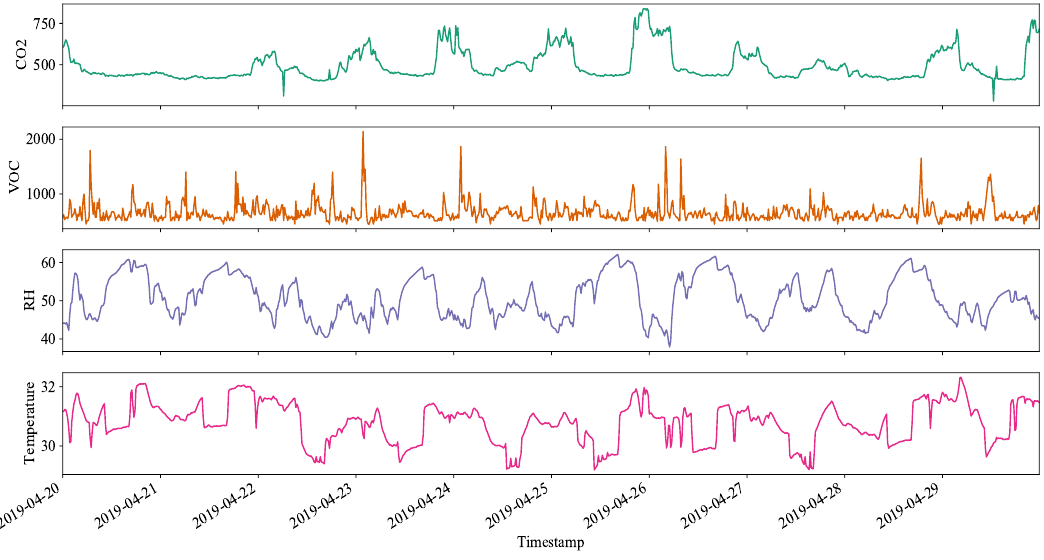
Figure 5. IAQ measurements for 10 days with 15 min